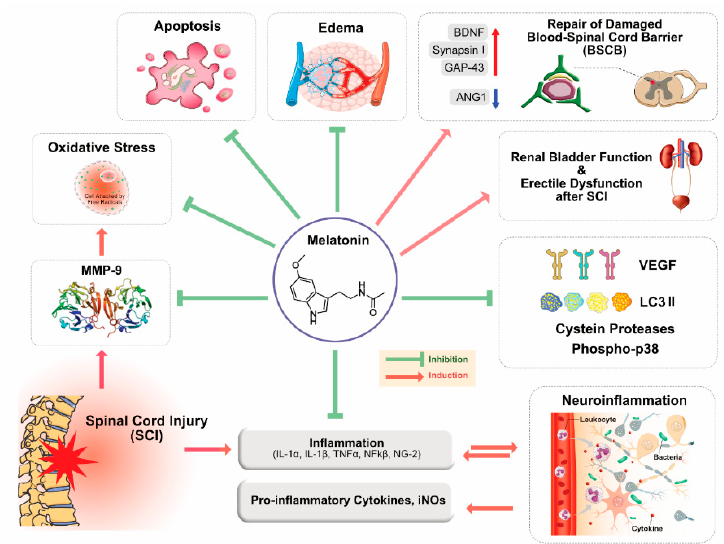
Figure 2. Potential mechanisms and beneficial effects of MLT in central nervous system (CNS)-related injuries. The concept was adapted and modified from Reference injuries. The concept was adapted and modified from Reference [75].